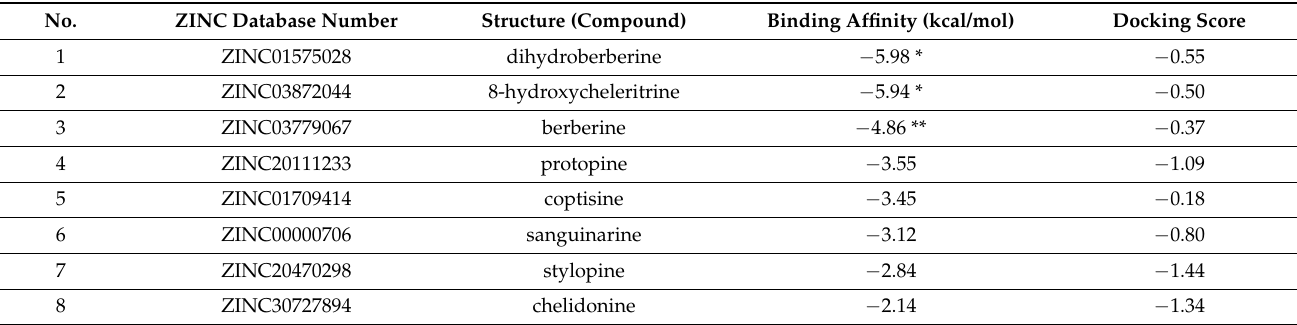
Table 2. Molecular docking of alkaloids detected in C. majus milky sap fractions with nucleolytic activity to the 3D model of MLP. * Binding affinity below − 5.00 kcal/mol is considered as high affinity. ** Binding affinity between − 5.00 and − 4.50 kcal/mol is considered as relatively high affinity.